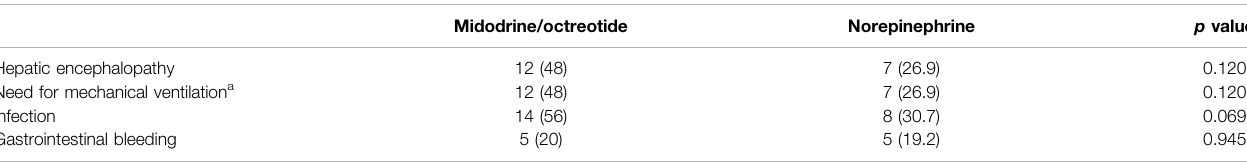
TABLE 3 | Serious adverse events experienced in both groups.